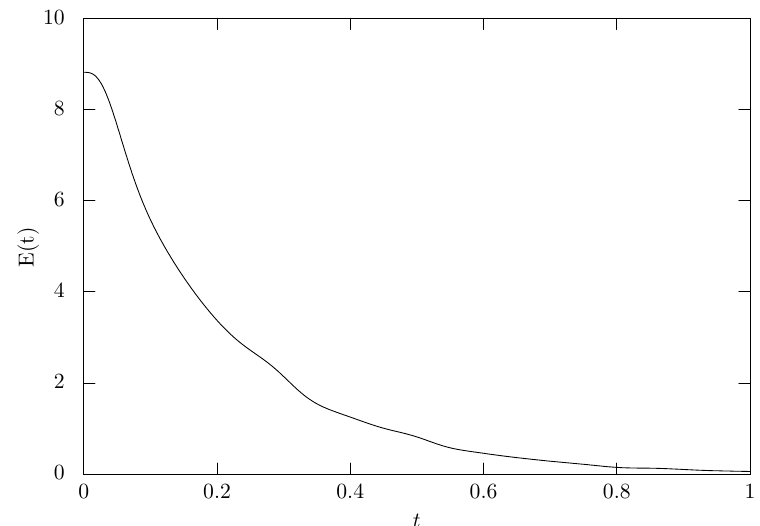
Figure 7. The total energy inEquation (91) of the coupled systems in Equations (87)—(89) with the damping terms. The energy is rapidly